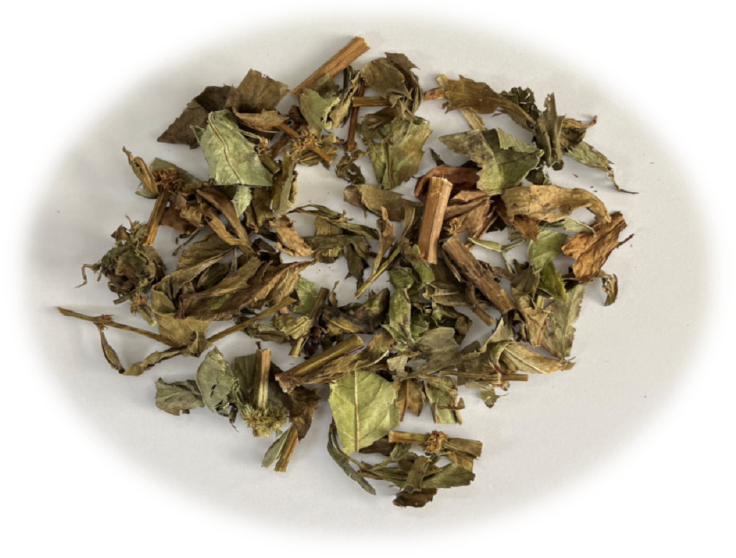
Figure 1. The plant studied, Lycopus lucidus Turcz.